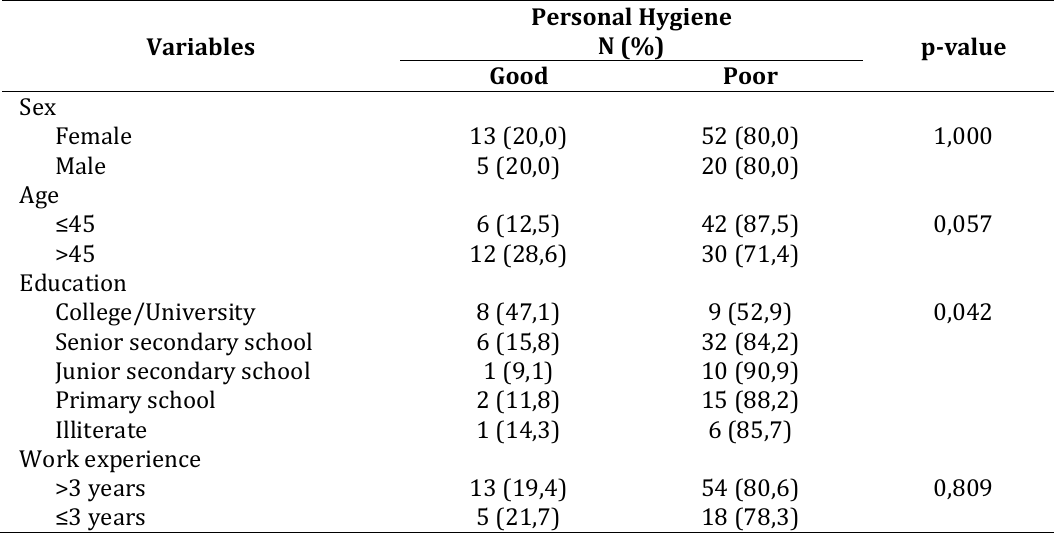
Table 2 Personal Hygiene of food handler based on socio-demographic characteristics